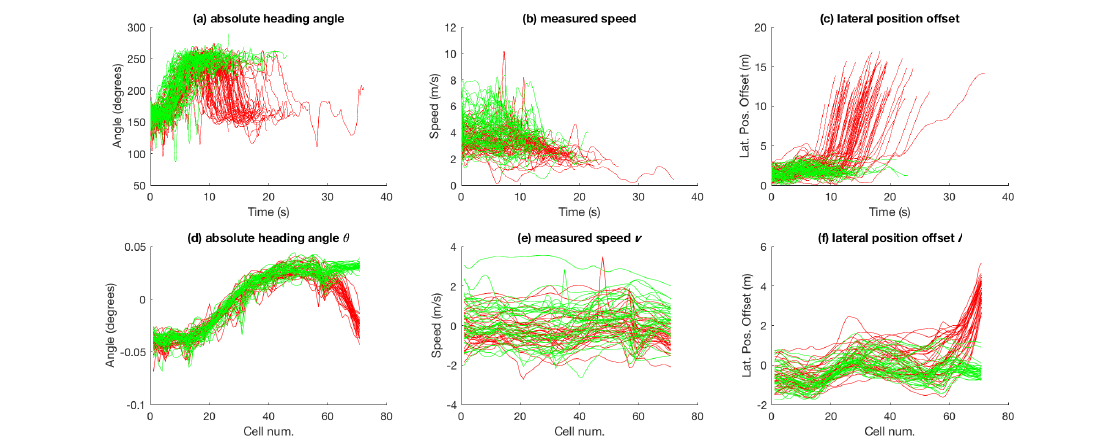
Figure 3. Attribute values for the bicycle dataset: ( a – c ) observations across time; and ( d – f ) grid-cell-wise zero-mean and unit-variance normalised attribute